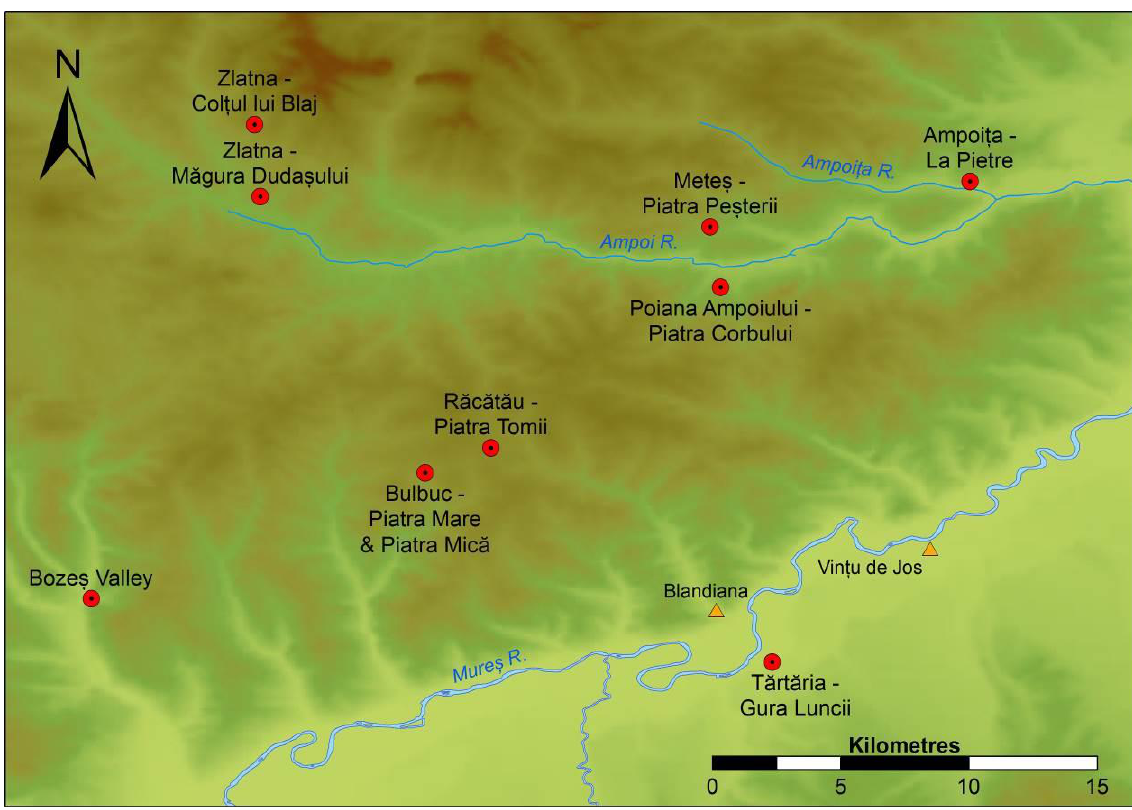
Figure 16. Map showing the location of Piatra Tomii relative to the Mureș and Ampoi Valleys as well as other contemporary archaeological sites (indicated by red circles on the map). (Modern settlements are indicated by